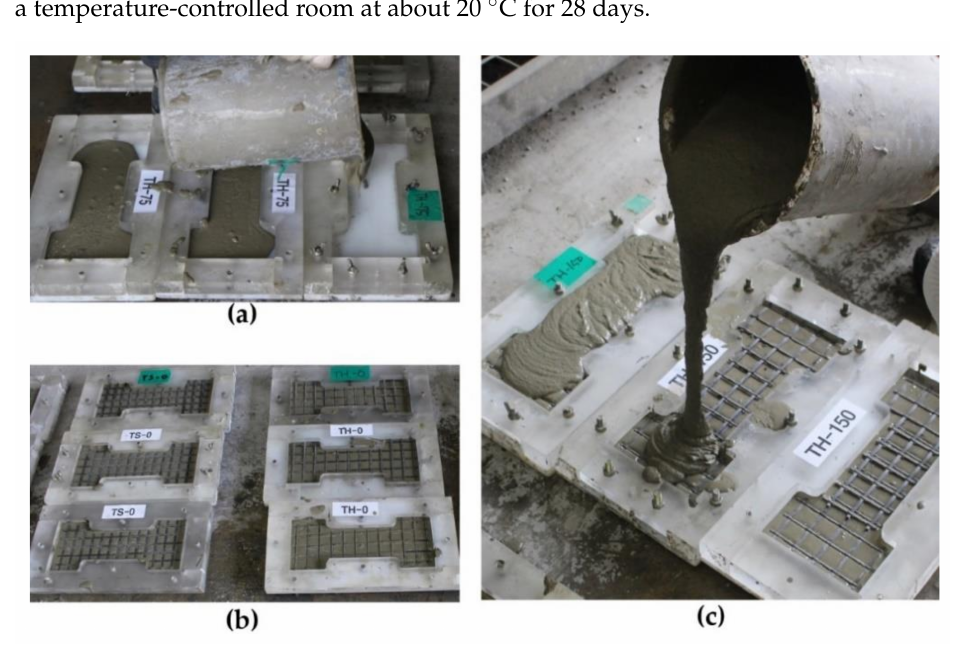
Figure 3. Fabrication process of tension test specimens: ( a ) placement of 1st layer of grout; ( b ) placement of textile grid; ( c ) placement of 2nd layer of